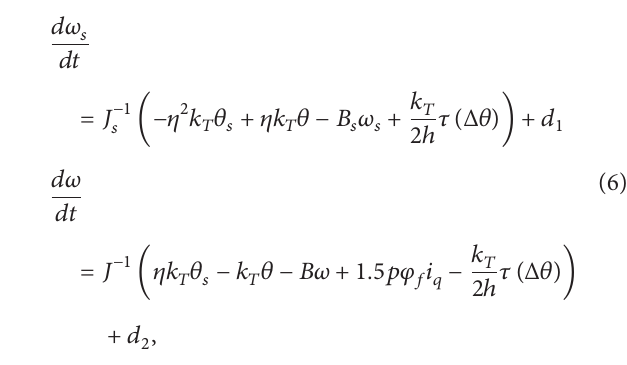
where ℎ is a positive parameter (refer to as smooth